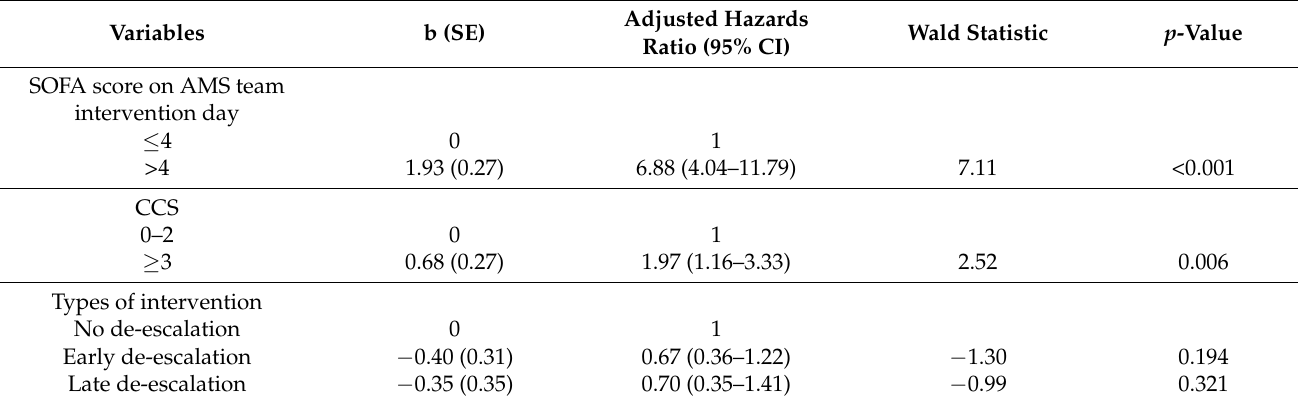
Table 9. Impact of antibiotic de-escalation after adjusting for SOFA score on intervention day and Charlson’s comorbidity